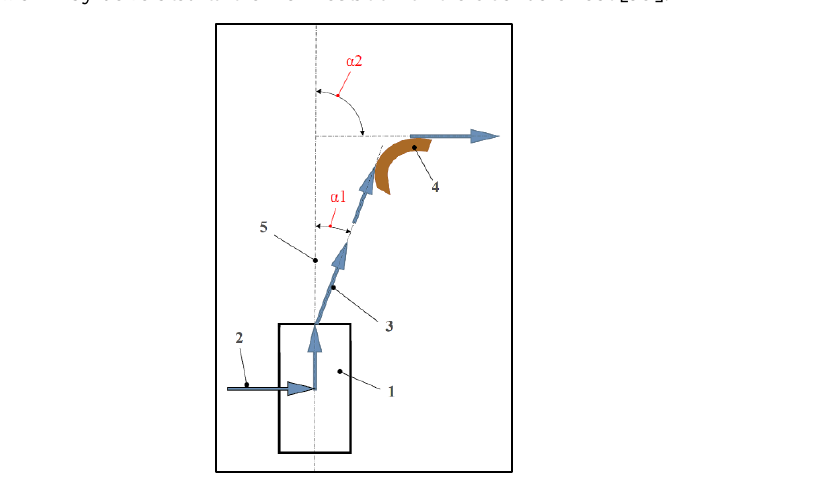
Figure 21. Switchgear diagram – variant No. 4: 1- switchgear; 2- inlet channel; 3- gas jet; 4- deflector; 5- axial